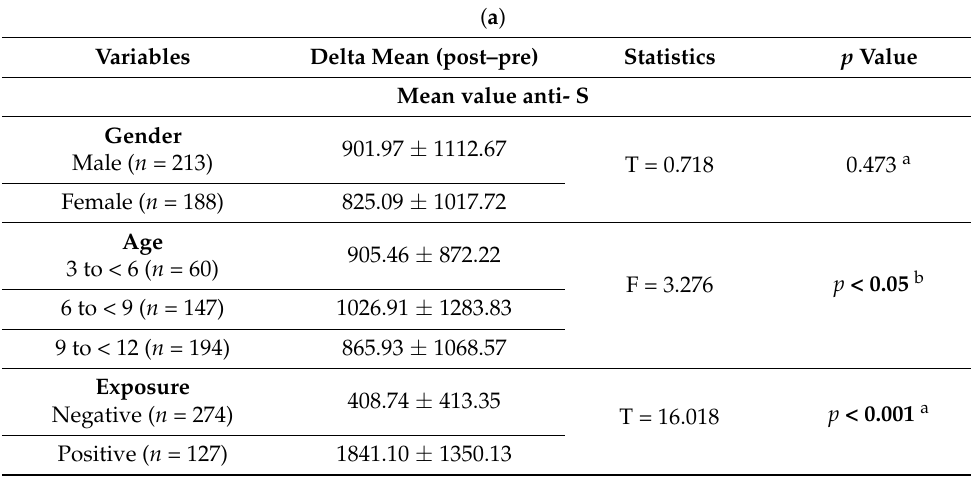
Table 6. ( a ) The comparison of the mean value of anti-S according to age, sex, and exposure. ( b ) The comparison of the mean value of anti-N according to age and sex and exposure. ( c ) The comparison of the mean value of neutralizing antibody with exposure (at day